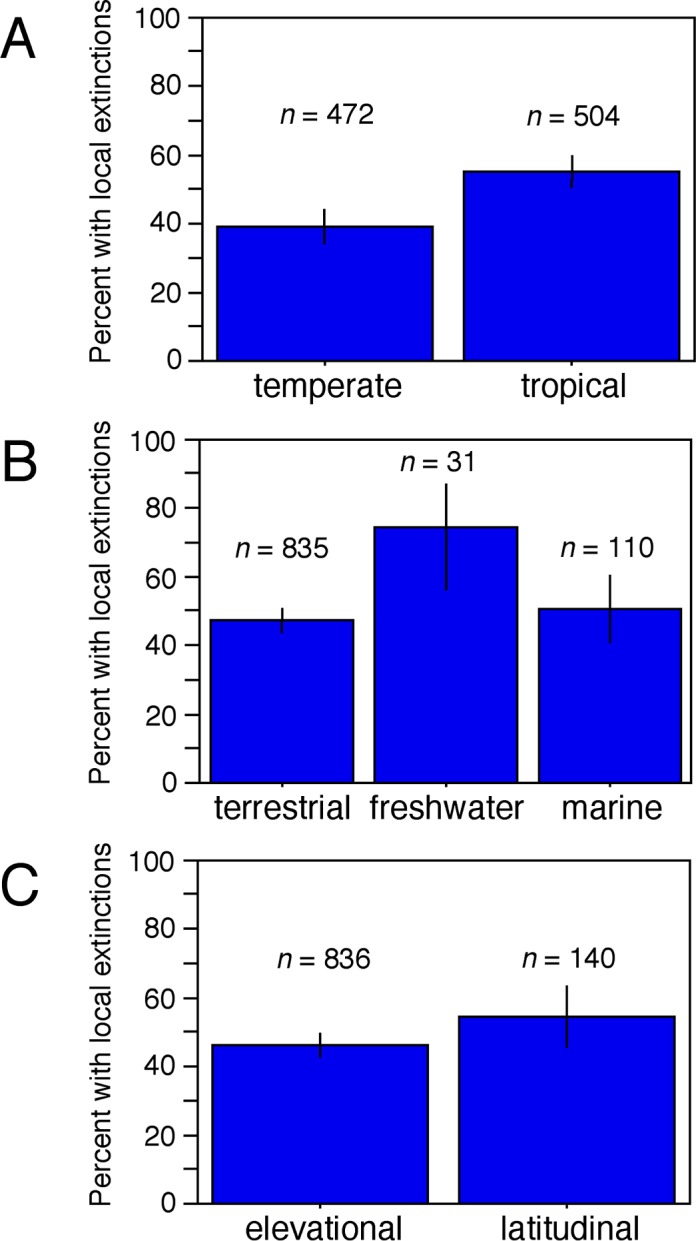
The frequency of local extinctions related to climate change across different climatic regions, habitats, and gradients.(A) Species are categorized as temperate or tropical (based on the location of the study), and the percentage of species with one or more local extinctions is shown, along with the sample sizes of species in each region. (B) Species are categorized as terrestrial, freshwater, or marine, and the frequency of species with local extinctions is shown (along with total species per habitat). (C) Species are categorized based on whether they were surveyed along elevational or latitudinal transects. Vertical lines indicate 95% confidence intervals on the estimated frequency of species with local extinctions.